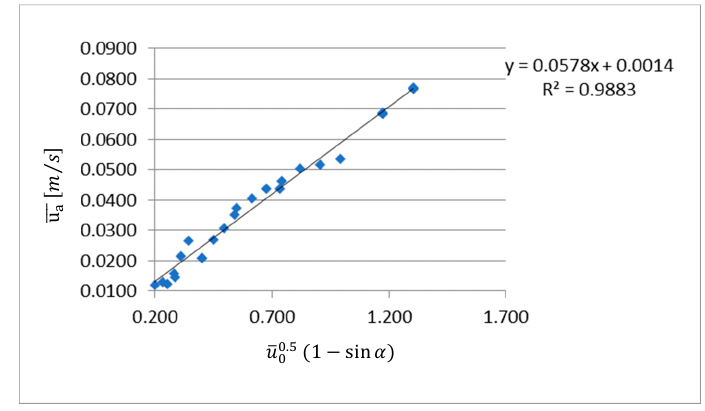
Figure 10. Linear regression between average velocity at the opening and u 00.5 ( 1 − sin α ) .